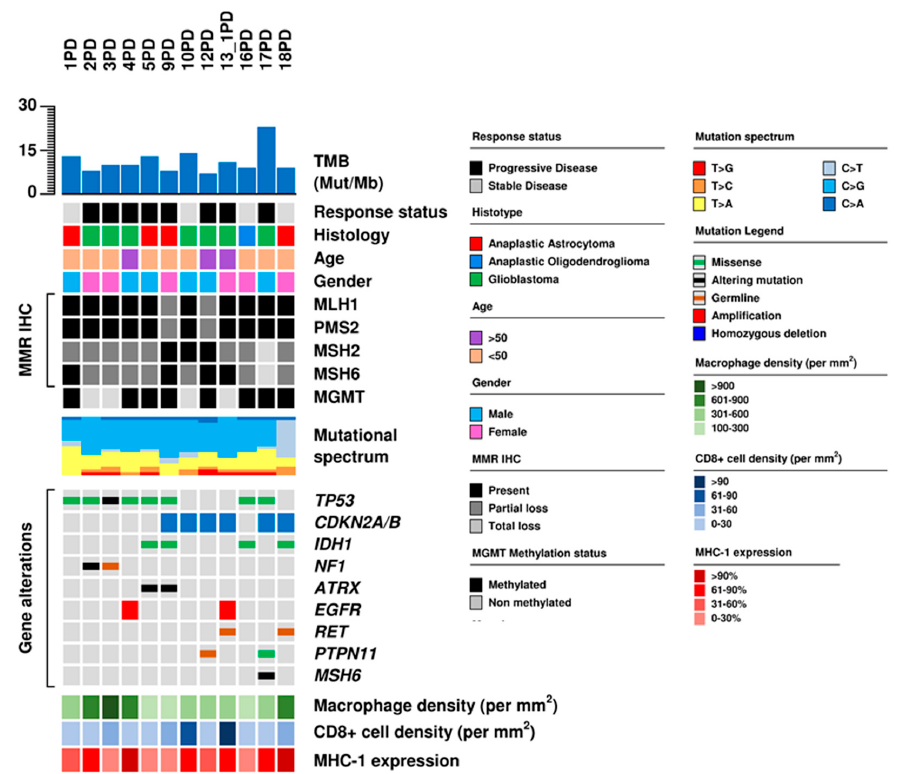
Figure 3. Genomic and immunological characteristics of 12 high-grade gliomas. The matrix shows the characteristics of each patient and matched tumor sample. Gene mutations, immunohistochemical analysis of genes involved in mismatch repair (MMR IHC), are correlated to histology, treatment response, tumor mutational burden (TMB) and immunological